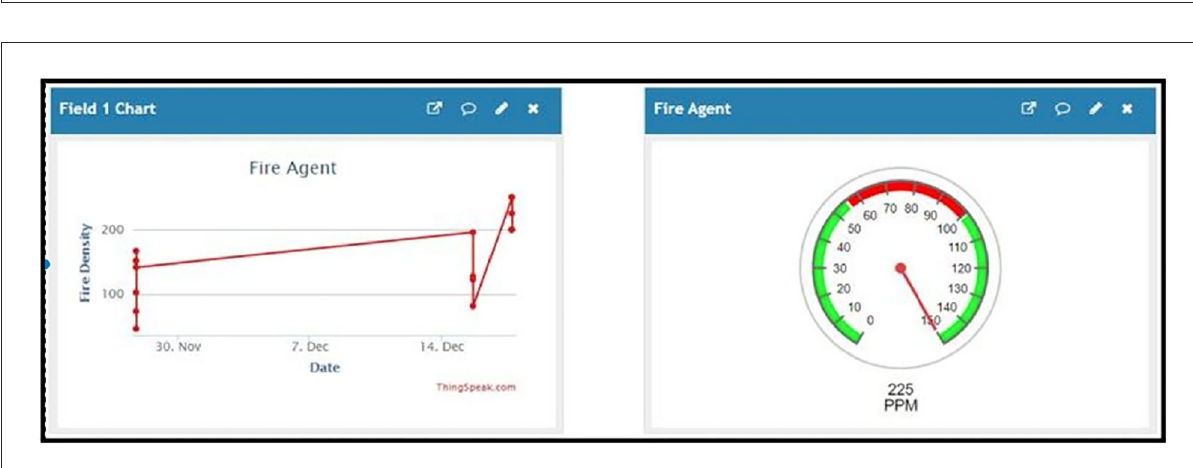
perception of the situation, the plan starts to execute whenever the event occurs. Every agent generates the optimal plan to acquire the desirable goals. New intentions can be formed